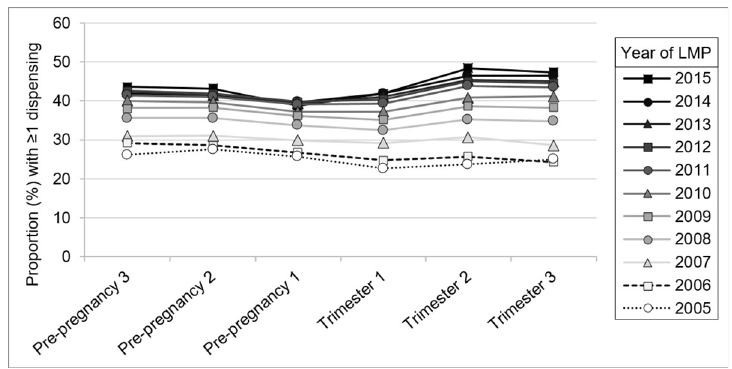
Fig 1. The proportion of pregnancies with at least one dispensing of a non-supplement prescription medicine. Pre-pregnancy 3 = 181–270 days pre-conception, Pre-pregnancy 2 = 91–180 days pre-conception, Pre-pregnancy 1 = 1–90 days pre-conception. The denominators for Trimesters 2 and 3 include only those pregnancies that persisted to the start of the respective trimester.